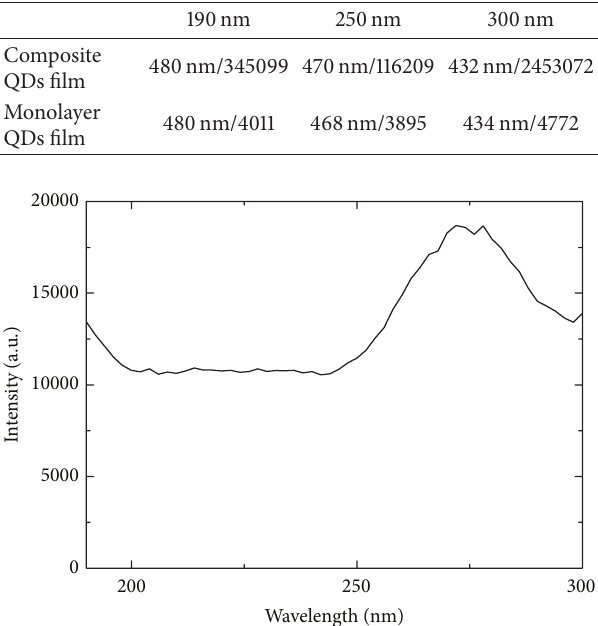
Table1:ThecenterwavelengthsandintensityofPLemissionspectra for monolayer and composite samples.